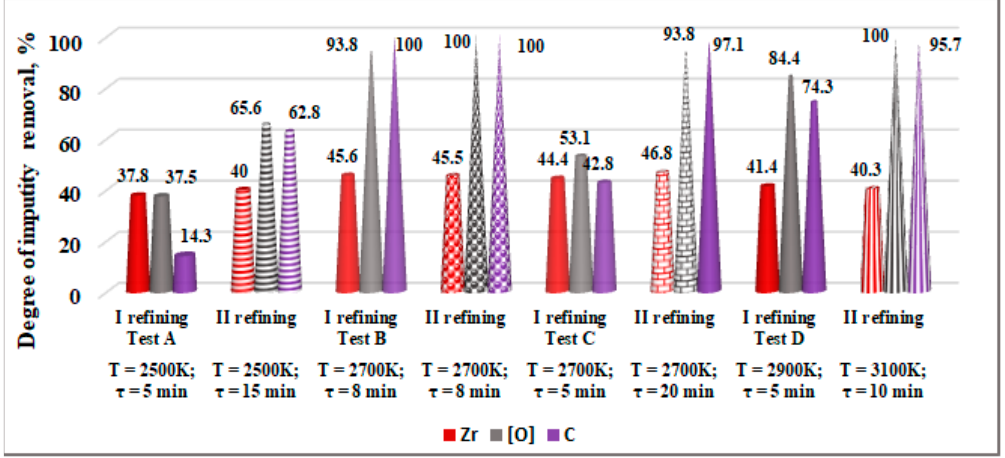
Figure 9. Influence of melting temperature and time on the degree of impurity removal at single and double refining from technogenic hafnium in vacuum.